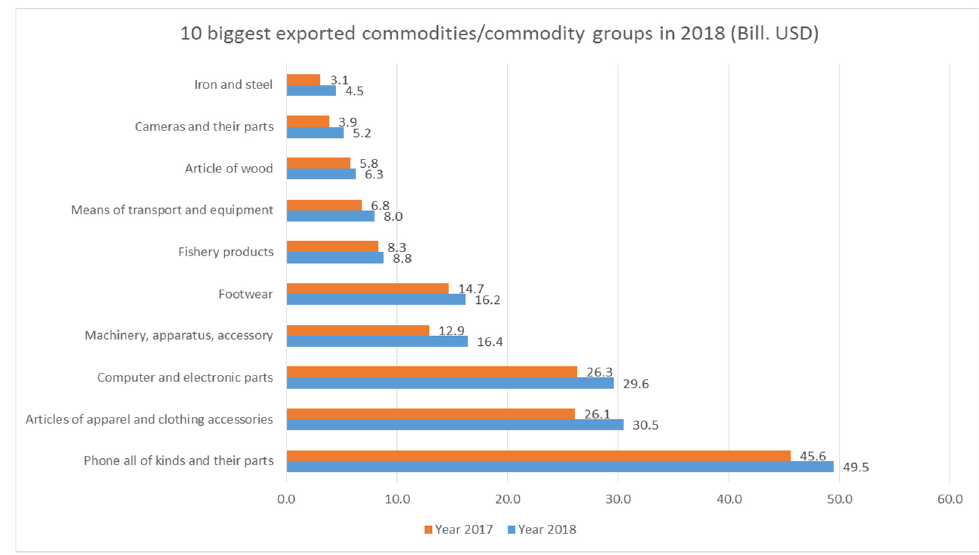
Figure 1. The ranking of exported commodities/commodity groups.